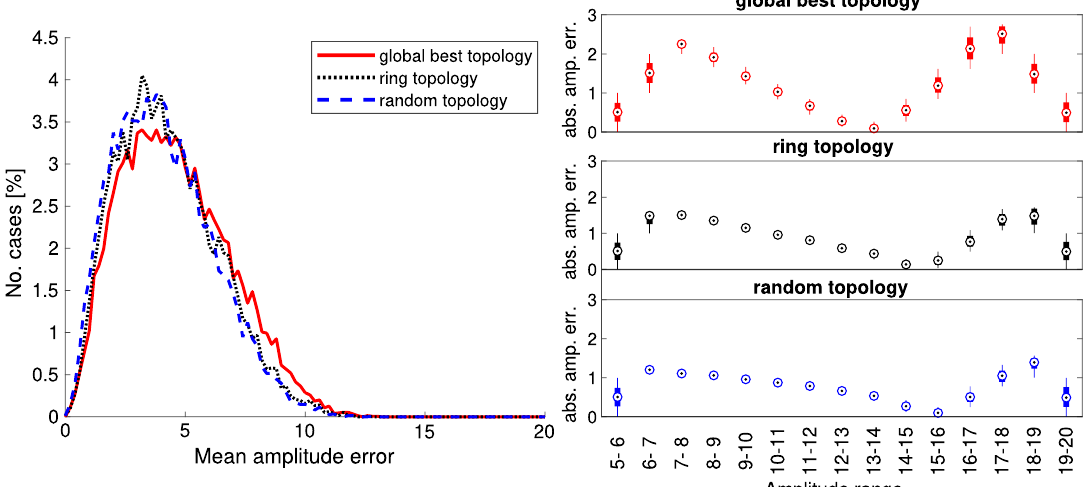
Figure 9. Distributions of mean amplitude errors ( left ) and box-and-whiskers plot of absolute amplitude errors dependent on true amplitude ranges ( right ).